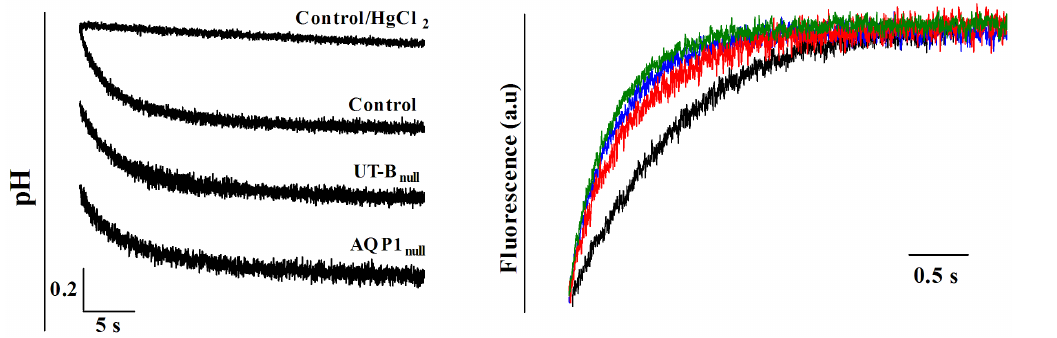
Figure 3. Comparison of Proton and ammonia transports in ghost from RBC variants. (A) Time course of intracellular pH decrease in ghosts subjected to pH gradient from 7.1 to 7.6. (B) Time course of fluorescence changes of ghosts derived from control (green), UT-B null (blue), AQP1 null (red), RhAG null (black) RBCs and subjected to 10 mM ammonium inwardly-directed gradient followed by stopped-flow analysis.